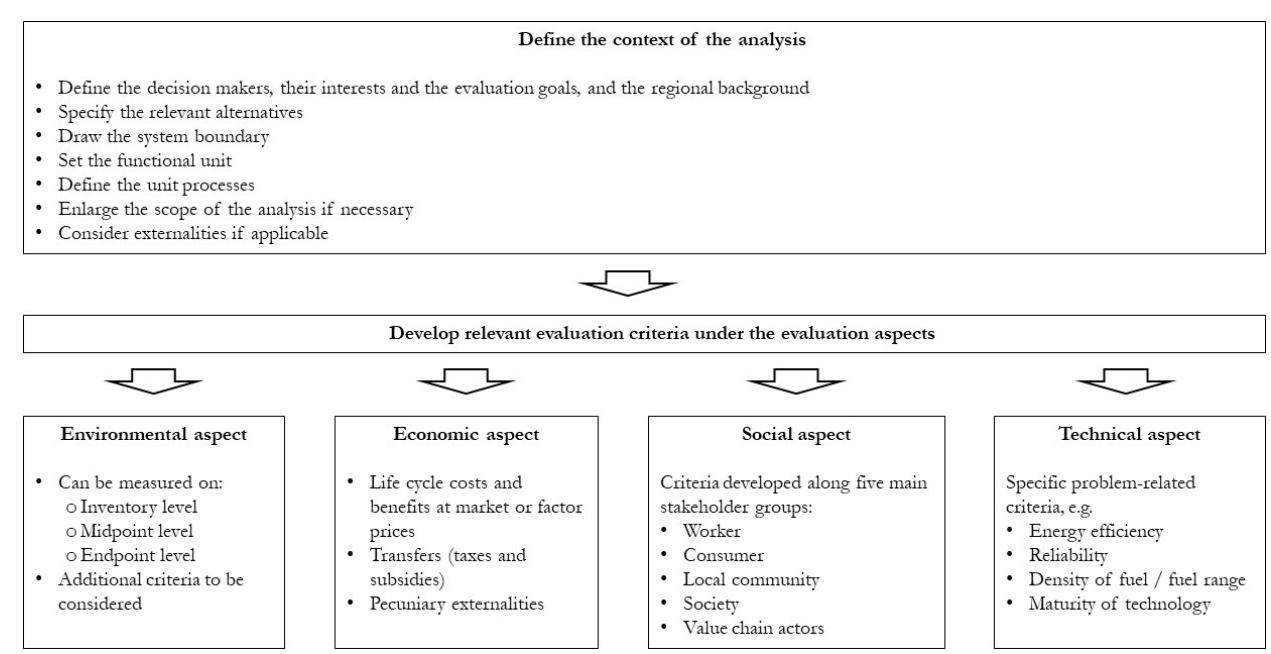
Figure 1. LCSA-based methodological framework for MCDA criteria selection.